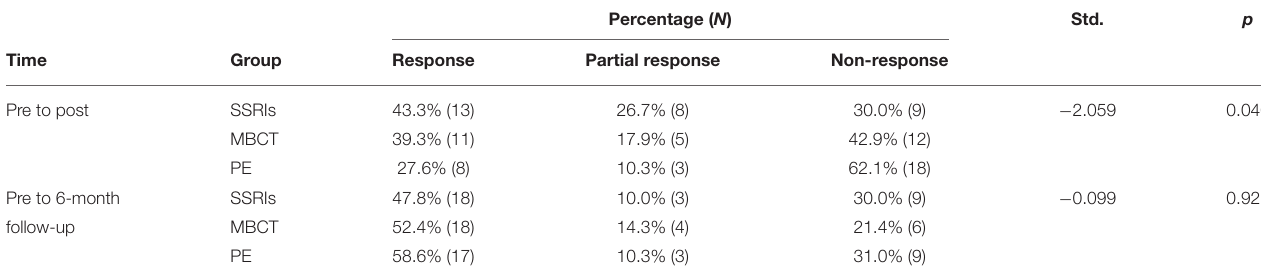
TABLE 2 | Non-parametric test results of treatment